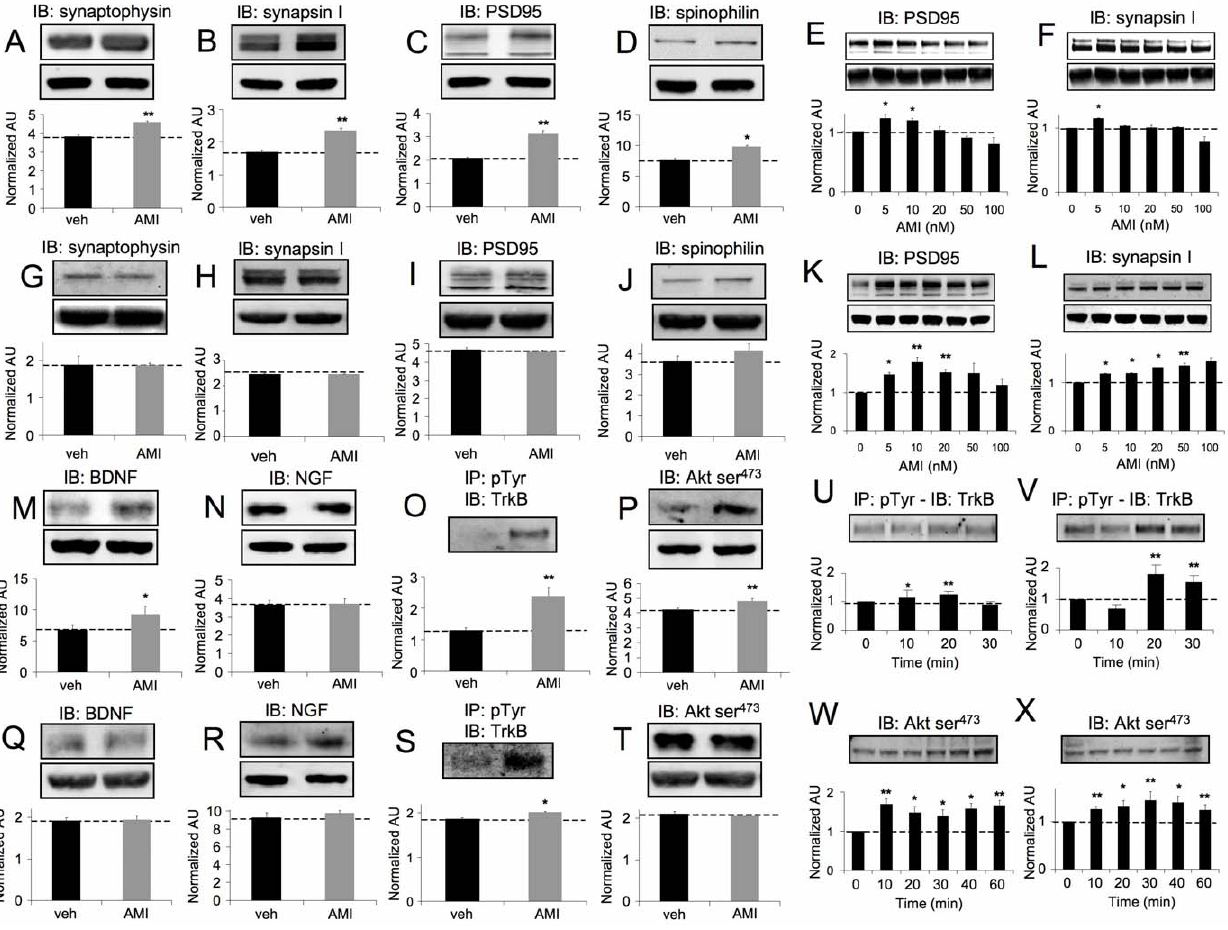
Figure 2. AMI alteration of various synaptic factors. AMI and vehicle (veh)-mediated effects upon hippocampal expression of (A) synaptophysin, (B) synapsin I, (C) PSD95 and (D) spinophilin. AMI effects on PSD95 (E) and synapsin I (F) expression in primary hippocampal cells. AMI/ veh-mediated effects upon cortical expression of (G) synaptophysin, (H) synapsin I, (I) PSD95 and (J) spinophilin. AMI effects on PSD95 (K) and synapsin I (L) expression in primary cortical cells. AMI modulation of hippocampal BDNF (M), NGF (M) levels, TrkB tyrosine phosphorylation (O) and Akt-serine (Ser)-473 phosphorylation (P). AMI effects upon TrkB tyrosine phosphorylation in primary hippocampal (U) or cortical neurons (V). AMI regulation of cortical BDNF (Q) or NGF (R) levels, TrkB tyrosine phosphorylation (S) and Akt-1 Ser-473 phosphorylation (T). AMI effects upon Akt-1 Ser- 473 phosphorylation in primary hippocampal (W) or cortical neurons (X). Western band intensities were quantified as actin-normalized arbitrary absorbance units